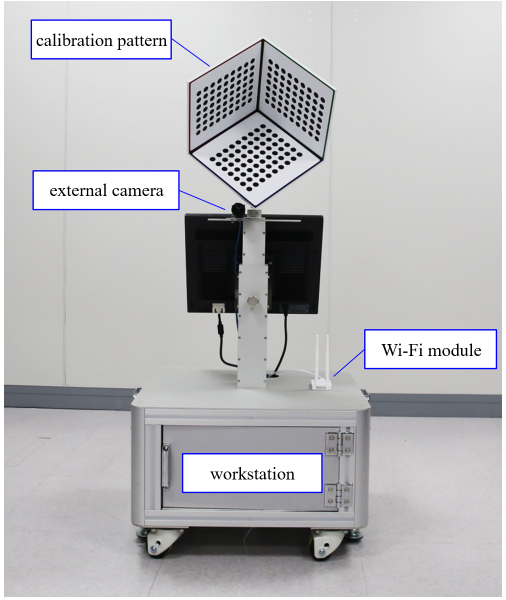
Figure 8. Calibration